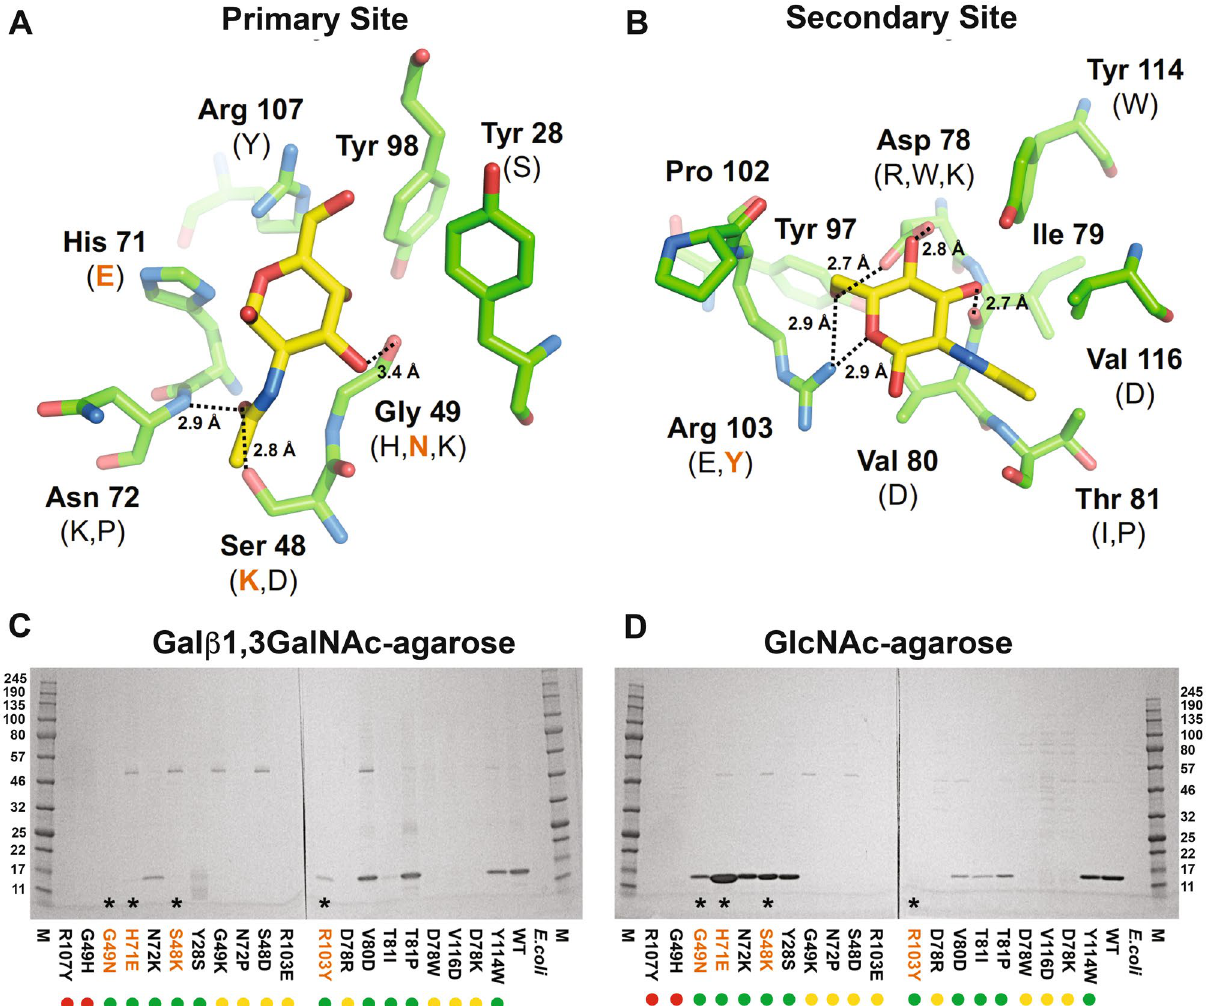
Figure 3. Modeled primary and secondary binding sites of rBGL. ( A ) Residues forming the primary binding site were mutated to specifically disrupt binding to GalNAc. ( B ) Secondary site residues were mutated to specifically disrupt binding to GlcNAc. Molecular graphic images were generated by V. Potapov using PyMOL 41 . All mutations tested are shown in parenthesis. Mutations that specifically abolish binding are highlighted in orange. Dotted lines indicate hydrogens bonds between the ligands and protein and the distance between donor and acceptor atoms is given in angstroms ( ). The overall structural model of rBGL is shown in Supplement Fig. S4. ( C , D ) Qualitative assessment of mutant lectin specificity. Computationally predicted mutants that Å disrupt each binding site were created by site directed mutagenesis and expressed in E. coli . Aliquots of each lysate were separately passed over Galβ1,3-GalNAc-agarose and GlcNAc-agarose columns. Proteins that bound to each column were eluted and separated by SDS-PAGE. Mutants G49N, H71E and S48K bound to GlcNAc but not Galβ1,3-GalNAc-agarose. Mutant R103Y bound to Galβ1,3-GalNAc but not GlcNAc-agarose. Recombinant BGL (WT) and E. coli extract were used as controls. Asterisks and colored text denote mutants with differential binding ability. To aid interpretation of binding trends, colored dots indicate the general level of expression of each mutant protein (green, soluble expression; yellow, poor/insoluble expression; red, no detected expression). M, broad range molecular weight protein standard (kDa, New England Biolabs catalog #P7712S). The uncropped gel images are shown in Supplement Fig.